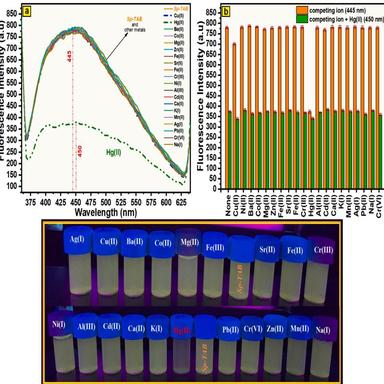
(a) Fluorescence spectra of Sp-TAB and Sp-TAB + metal ions (in ethyl alcohol/H2O (3:7)) suspension mixtures. (b) Selectivity of the Sp-TAB towards other metals with/without Hg(II) ion. (Error analysis has been marked with error bars.).